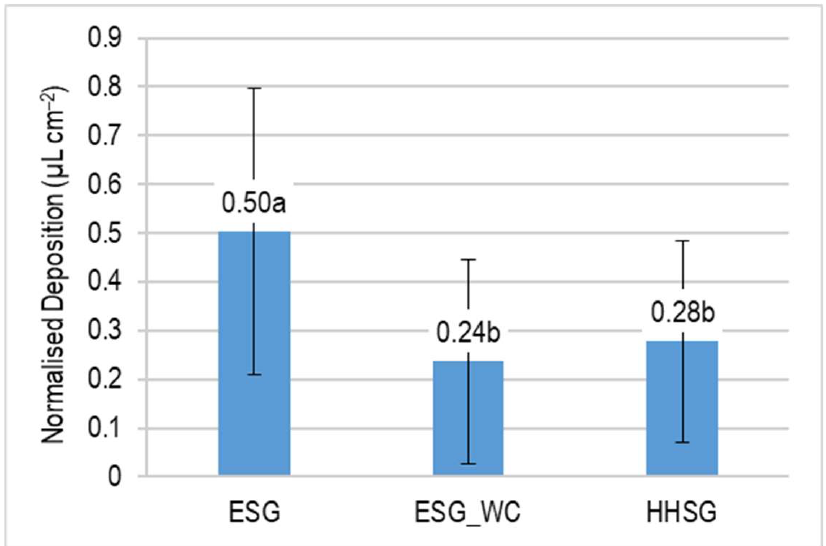
Figure 5. Normalised deposition on the underside of the leaves (µL cm −2 ). The same letter signifies no significant differences (Duncan’s test, p < 0.05). Bars signify the means ± SD of the data. ESG: Electrostatic Spray Gun; ESG_WC: Electrostatic Spray Gun Without Charge; HHSG: Hand-Held Spray Gun.